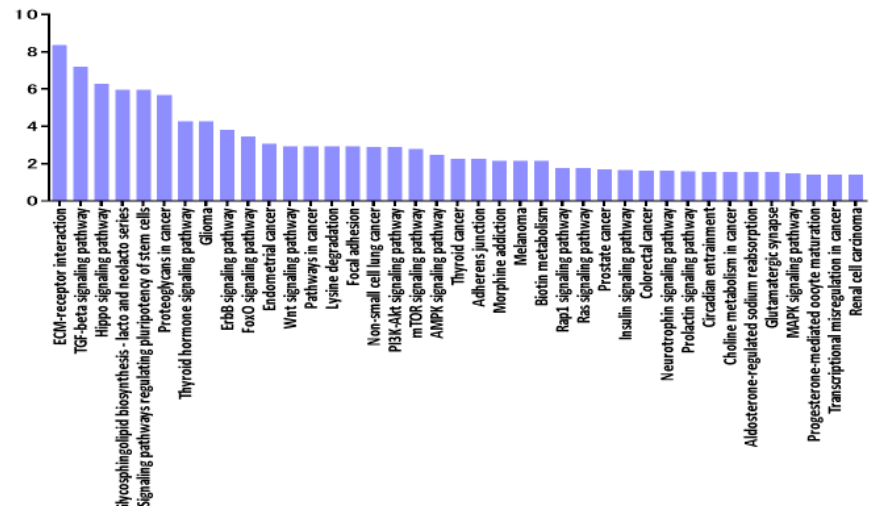
Figure7. Histogrampresentingpathwaysenrichedindi ff erentiallyexpressedmRNAsinvitreousofVRL patients compared with uveitis with vitreous opacity. y axis: − log 10 ( p -value). ECM: extracellular matrix, TGF: transforming growth factor, FoxO: forkhead box O, PI3K-Akt: phosphatidylinositol